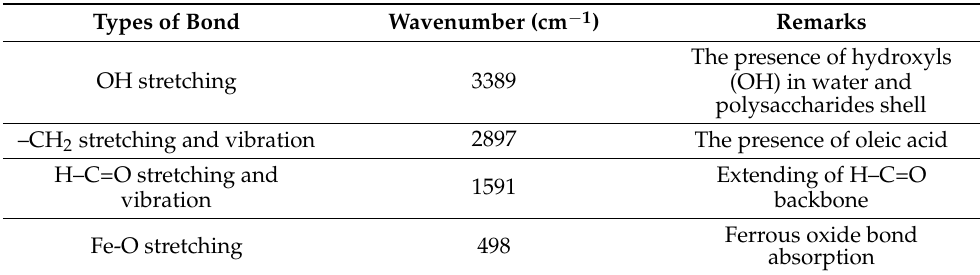
Figure 4. Energy dispersive spectrometry (EDS) of MNP. Table 3. Elemental compositions of MNP. Table 4. FTIR peaks of MNP.